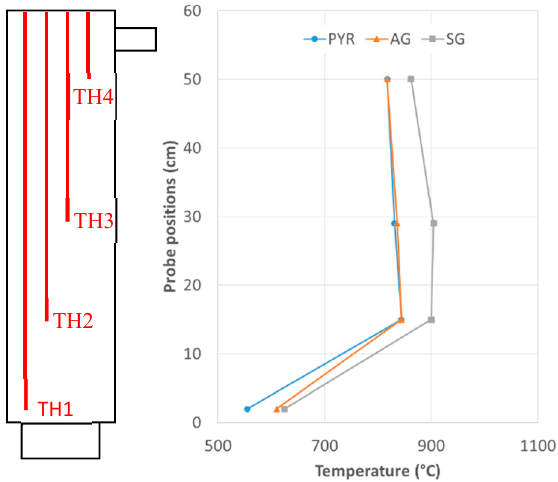
Figure 3. Temperature distribution within the reactor during PYR, AG and SG tests.